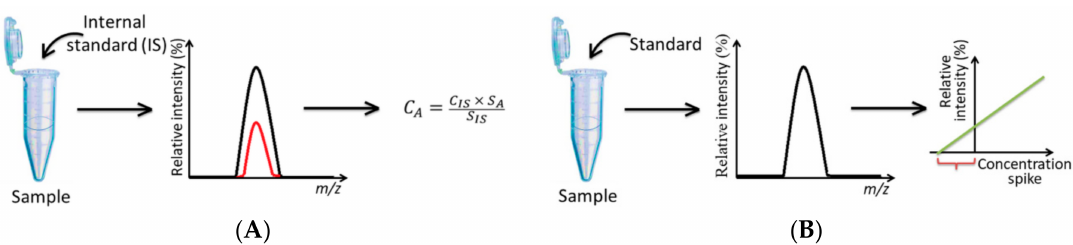
Figure 4. Stable isotope dilution ( A ) and standard addition ( B ) approaches for quantification of glycation